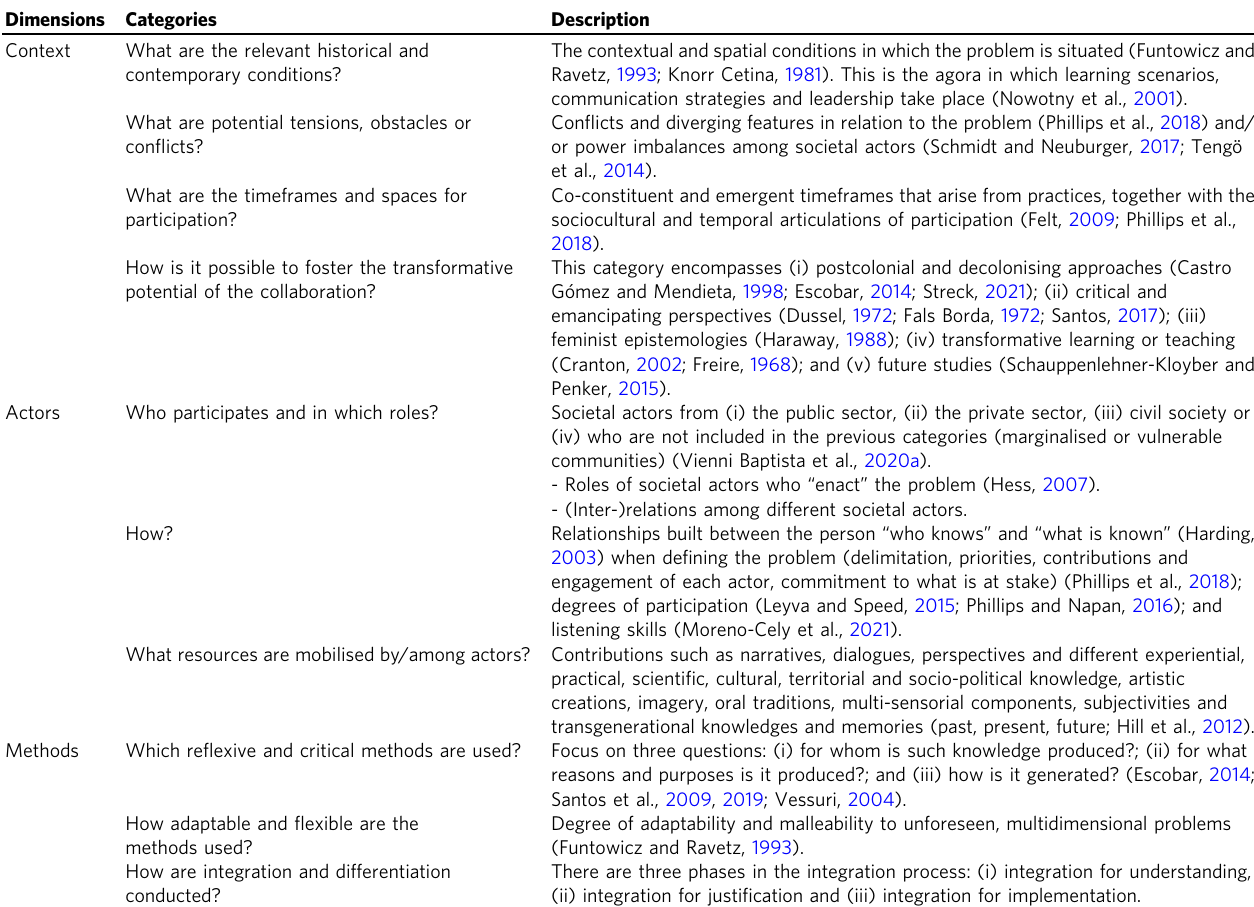
Table 1 Dimensions, categories, and prompts of the heuristic